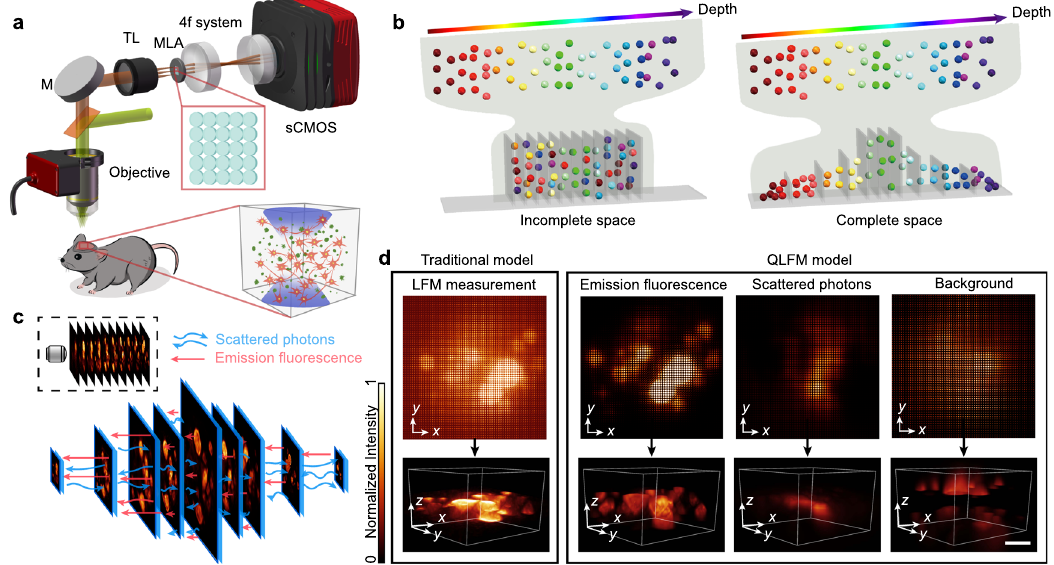
Fig. 1 Schematic of quantitative light- fi eld microscopy (QLFM). a Experimental setup of our QLFM system with a simple microlens array (MLA) inserted at the image plane for snapshot phase-space measurements. M mirror, TL tube lens, sCMOS (scienti fi c complementary metal-oxide semiconductor) camera. b Concept of the multiscale model. Incomplete space used in the reconstruction of traditional LFM results in strong background noises and loss of quantitative properties in complicated environments. We apply different sampling rates in 3D based on the effective resolution of LFM at different axial planes to model a large volume for background rejection with an orders-of-magnitude reduction in computational costs. c Schematic of the multiscale scattering model. We differentiate the multiple-scattered photons from native emission fl uorescence in the multislice model based on the fi rst Born approximation to retrieve 3D fl uorescence quantitatively in deep tissue. d Comparisons between traditional LFM and QLFM by imaging the same GFP- labeled B16 tumor spheroid. With a more accurate physics model to describe the imaging process, QLFM can separate the spatially nonuniform background and scattered photons from native 3D emission fl uorescence, facilitating computational optical sectioning. Scale bars, 30 μ